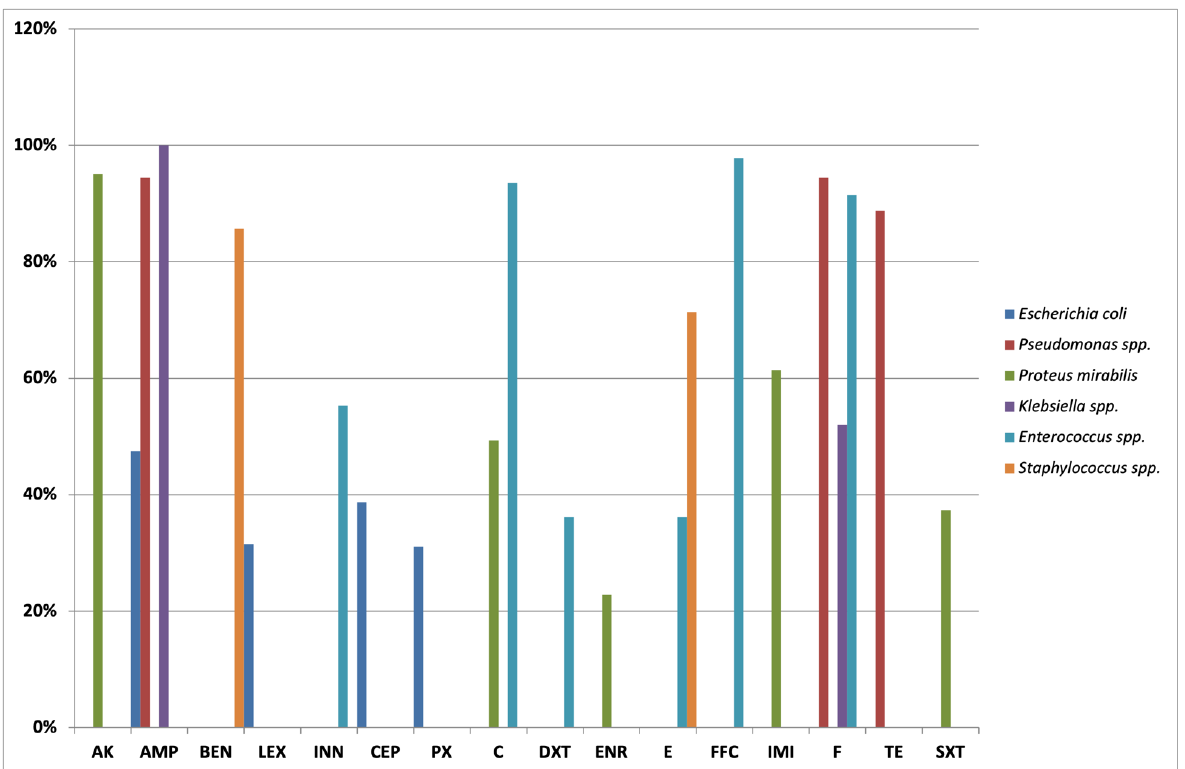
Figure 1. Antimicrobial resistance frequencies (% of resistant bacteria) detected in isolates from urine samples of dogs. The percentage values greater than or equal to 10% are reported. AK: